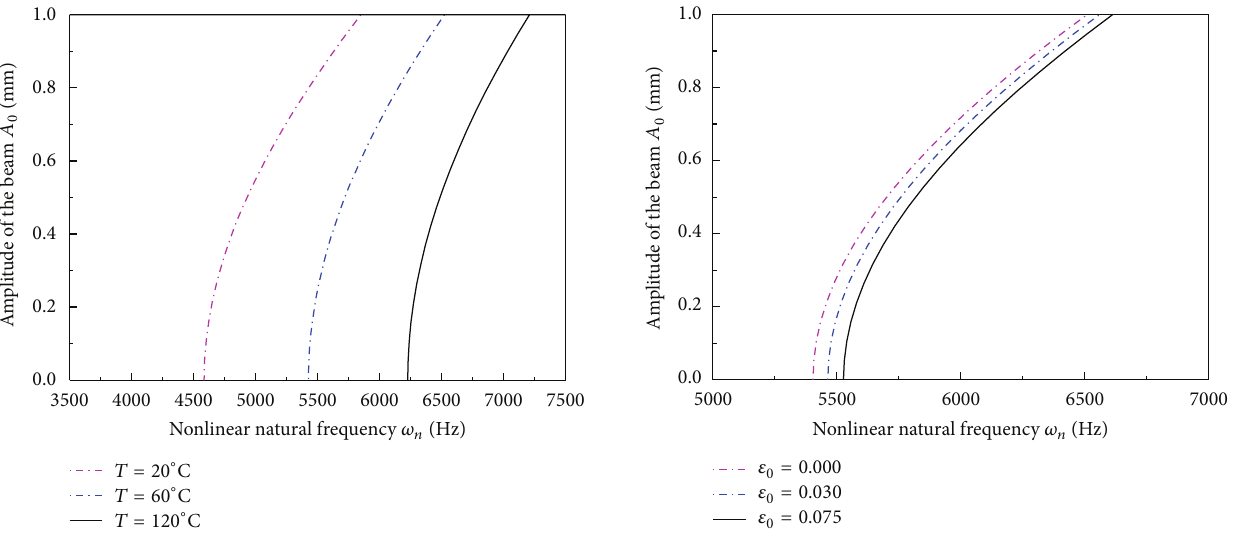
Figure 7: Variation of the nonlinear natural frequency with the free vibration amplitude 𝐴 0 for different T ( 𝑉 𝑠 = 0.005 , 𝜀 0 = 0.01 , and 𝐿/ℎ = 10 ).